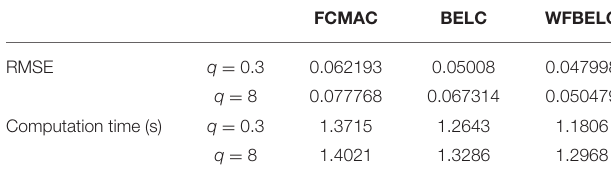
TABLE 1 | Results for Duffing-Holmes chaotic system.